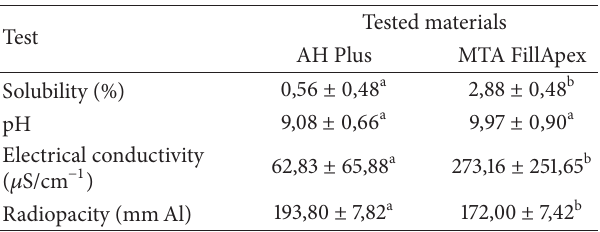
Table 2: Physicochemical properties of the tested materials (mean ± standard deviation).